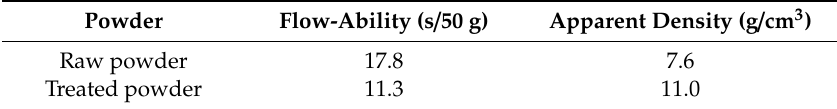
Table 1. Flow-ability and apparent density of the raw powder and the treated powder. Powder Flow-Ability (s / 50 g) Apparent Density (g / cm 3 ) Raw powder Treated powder